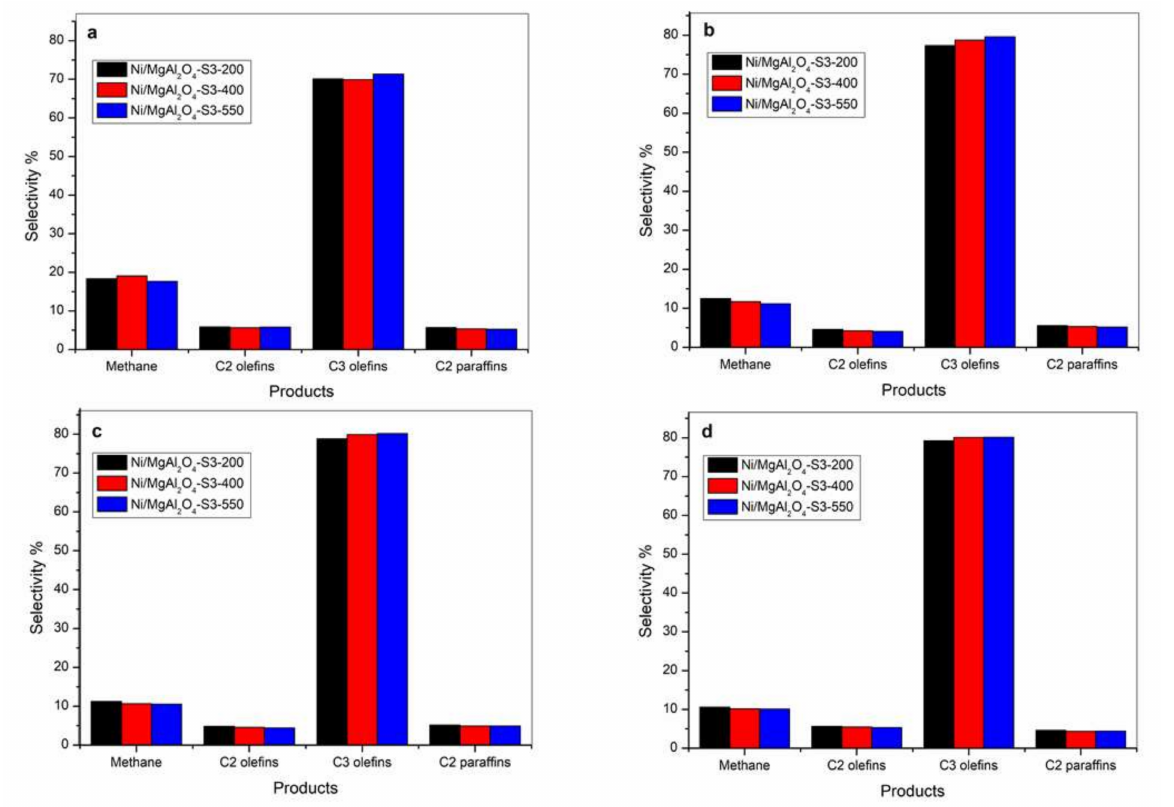
Figure 19. Selectivity % of Ni/MgAl 2 O 4 sulfided with DMSO at ( a ) 3 min, ( b ) 30 min, ( c ) 60 min, and ( d ) 120